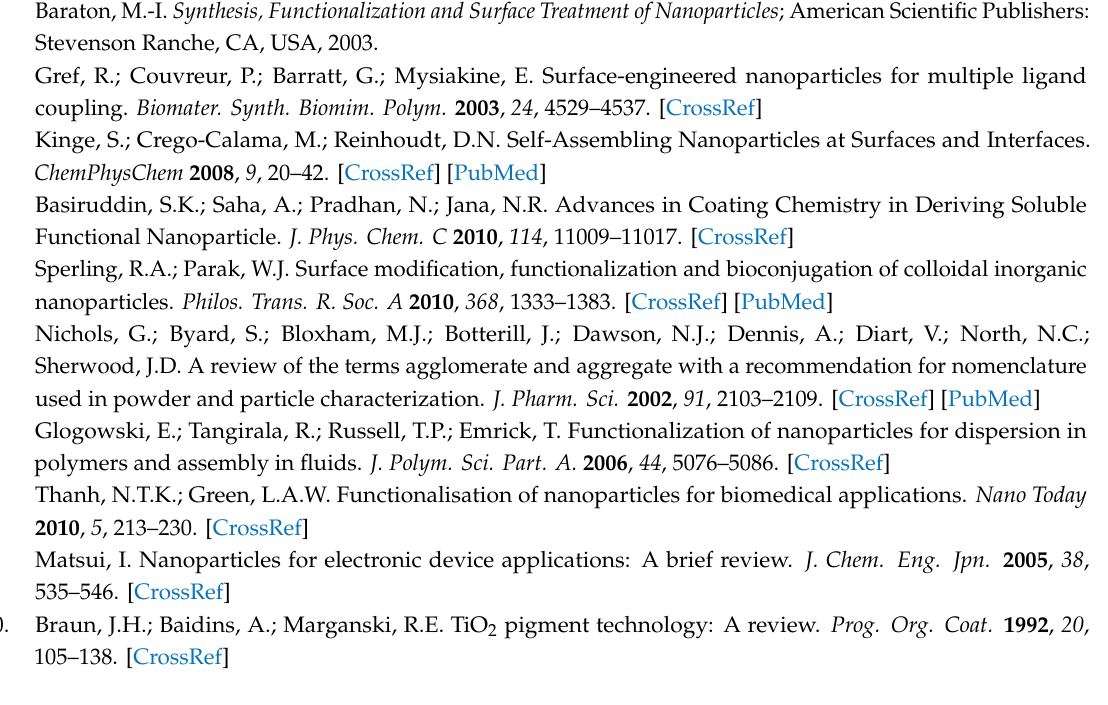
Figure S1: TGA curve of NM-300K., Figure S2: Illustrative chromatograms of extracts of the di ff erent types of MNM, Figure S3: Water loss of MNM estimated by TGA from 25–110 ◦ C at 10 ◦ C / min versus the laboratory furnace method. Table S1: Available information on the studied MNM, Table S2: Identified and un-identified organic compounds associated with